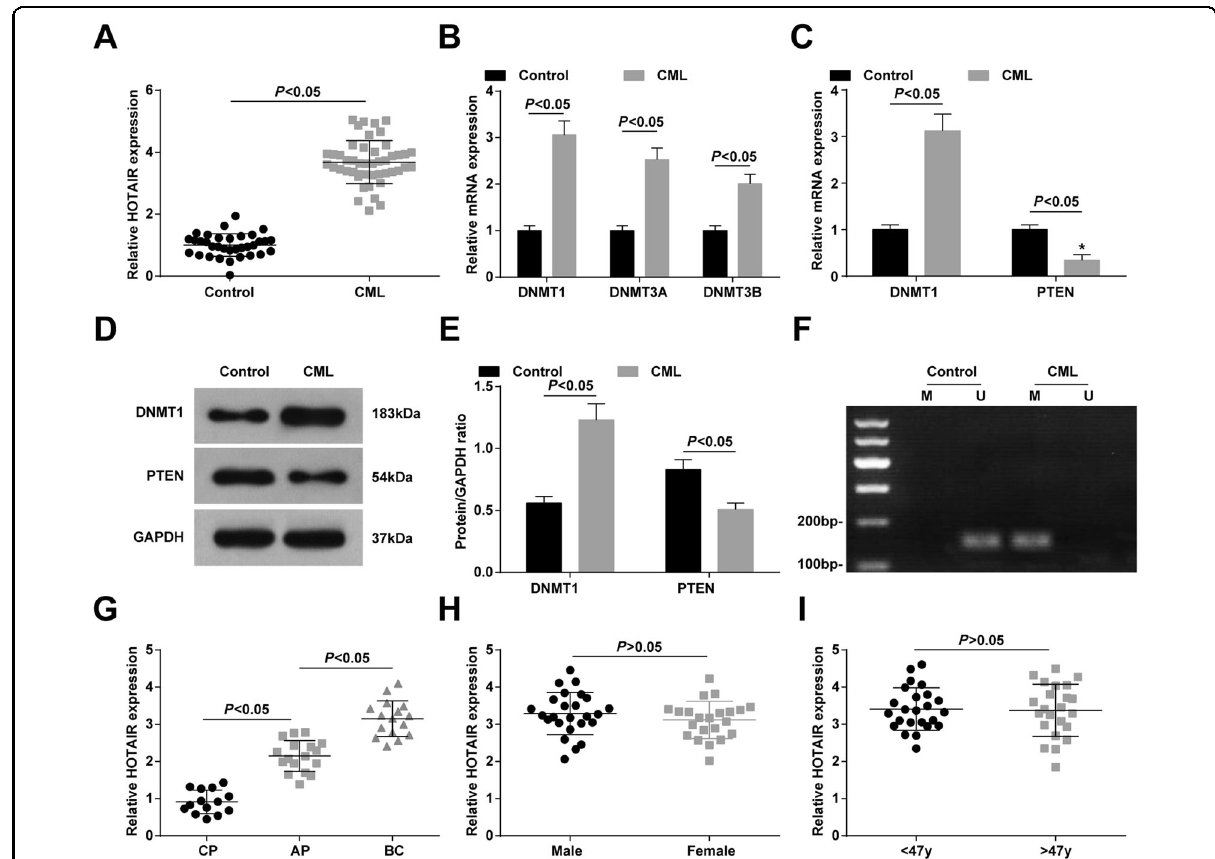
Fig. 1 HOTAIR and DNMT1 expression are raised, and PTEN is reduced in bone marrow of CML patients, and overexpression of HOTAIR is related to poor prognosis of CML patients. A Expression of HOTAIR in patients with CML. B Expression of methyltransferase in patients with CML. C Expression of DNMT1 and PTEN mRNA in patients with CML. D Protein bands of DNMT1 and PTEN in patients with CML. E DNMT1 and PTEN protein expression levels in CML patients. F PTEN methylation in CML patients. G Effect of WHO classi fi cation on HOTAIR expression. H Effect of gender on HOTAIR expression. I Effect of age on HOTAIR expression (control group, n = 34; CML group, n = 47; CP group, n = 14; Ap group, n = 17; BC group, n = 16; male group, n = 25; Female group, n = 22; <47 y group, n = 24; >47 y group, n = 23). Measurement data were depicted as mean ± standard deviation, comparisons between two groups were conducted by independent sample t